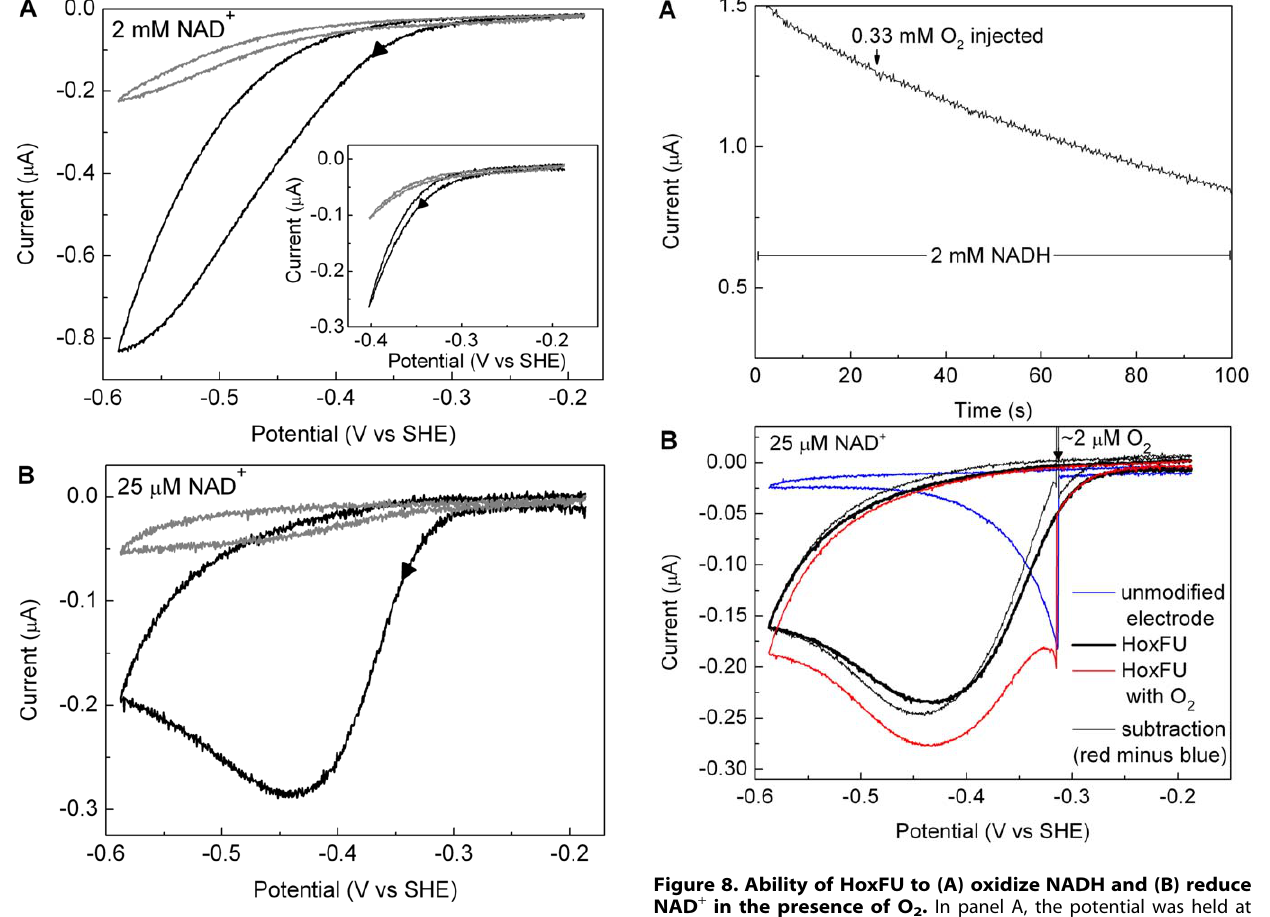
Figure 7. Cyclic voltammograms showing irreversible inactiva- tion of HoxFU at low potentials at different NAD + concentra- tions. In each case the scan rate was 1 mV/s, the electrode was rotated at 2500 rpm, and other conditions were: 50 mM Tris-HCl buffer, pH 8.0, 30 u C; (A) 2 mM NAD + and (B) 25 m M NAD + . The first cycle for each film is shown as a thick line and the second cycle is shown as a thin line. Arrows indicate the direction of scan. Inset in (A) shows a scan over a narrower potential range.